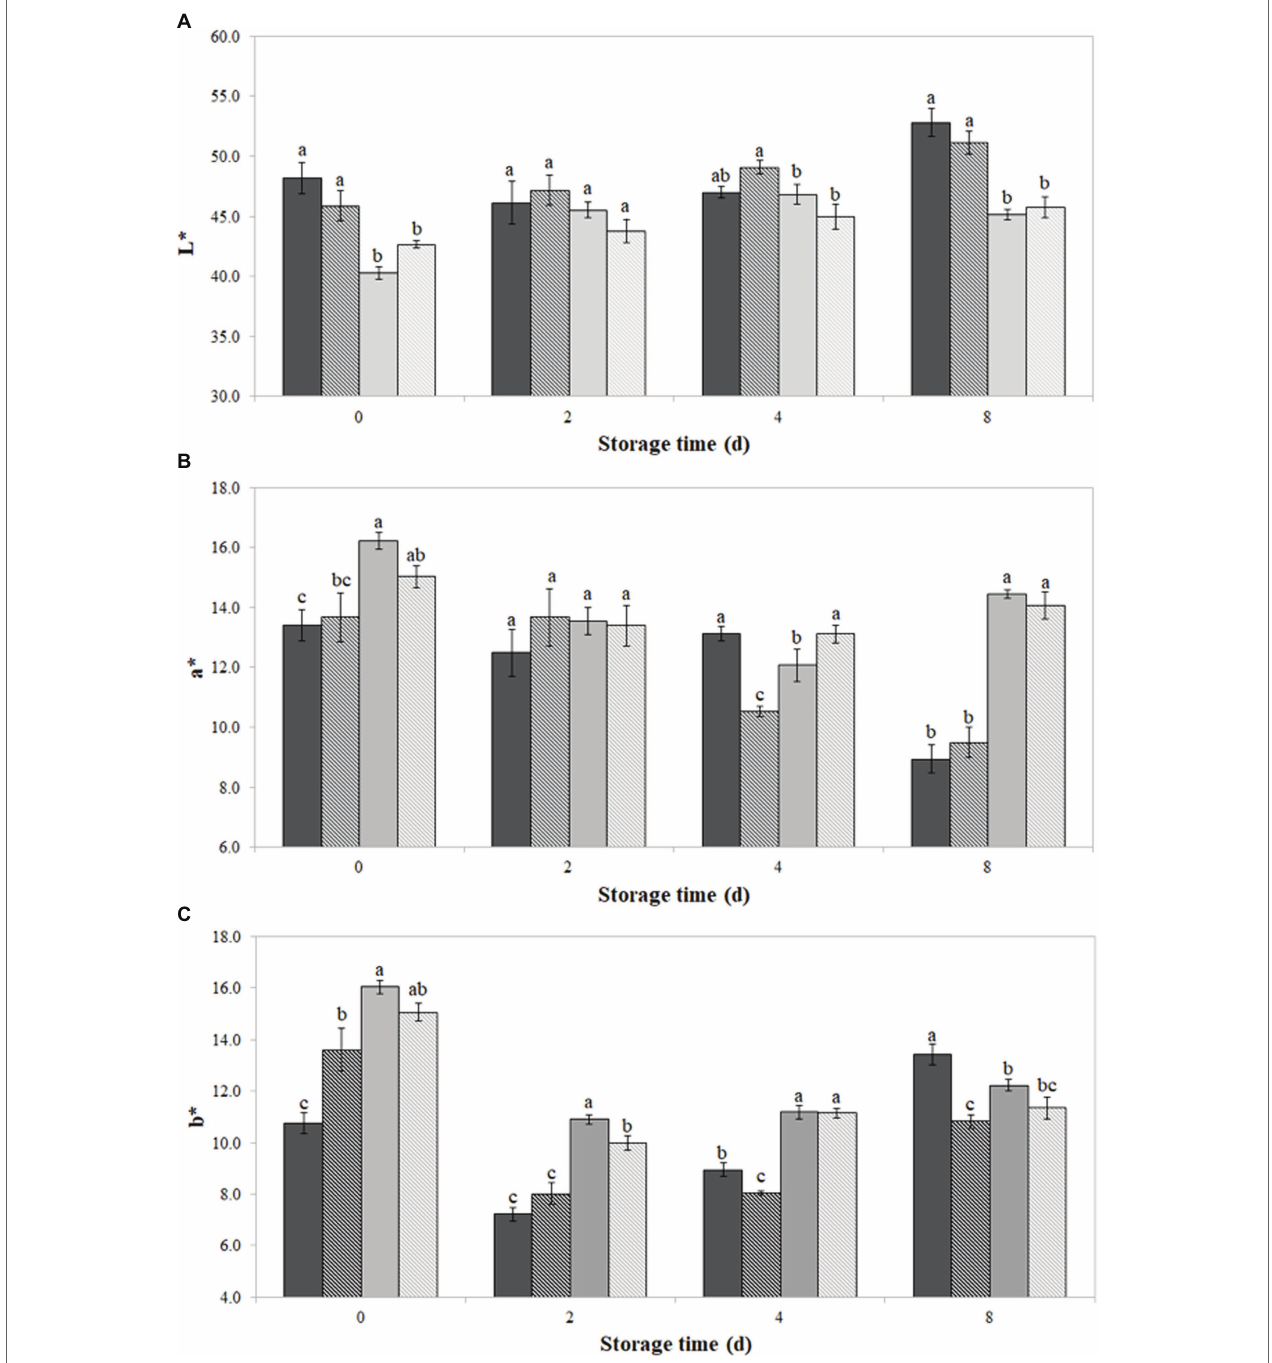
FIGURE 2 | Color values L* (A) , a* (B) , and b* (C) of burger patties incorporating prickly pear extract (PPE) and encapsulated prickly pear extract (Encaps-PPE). Controls were made incorporating sterile distilled water (SDW) or encapsulated sterile distilled water (Encaps-SDW). Color parameters were measured in burger surface up to 8 days of storage at 4 ± 1 ° C. Vertical bars indicate the standard deviation of the mean. SDW Encapsulated-SDW PPE